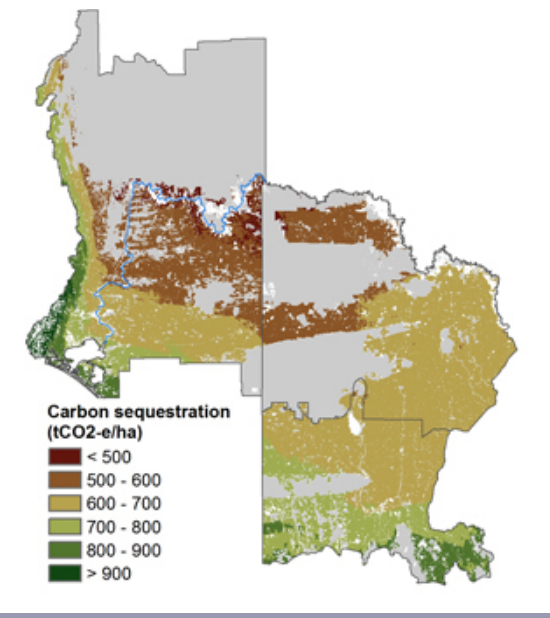
Fig. 2 . Total carbon sequestration in the study area over 64 years as modeled by